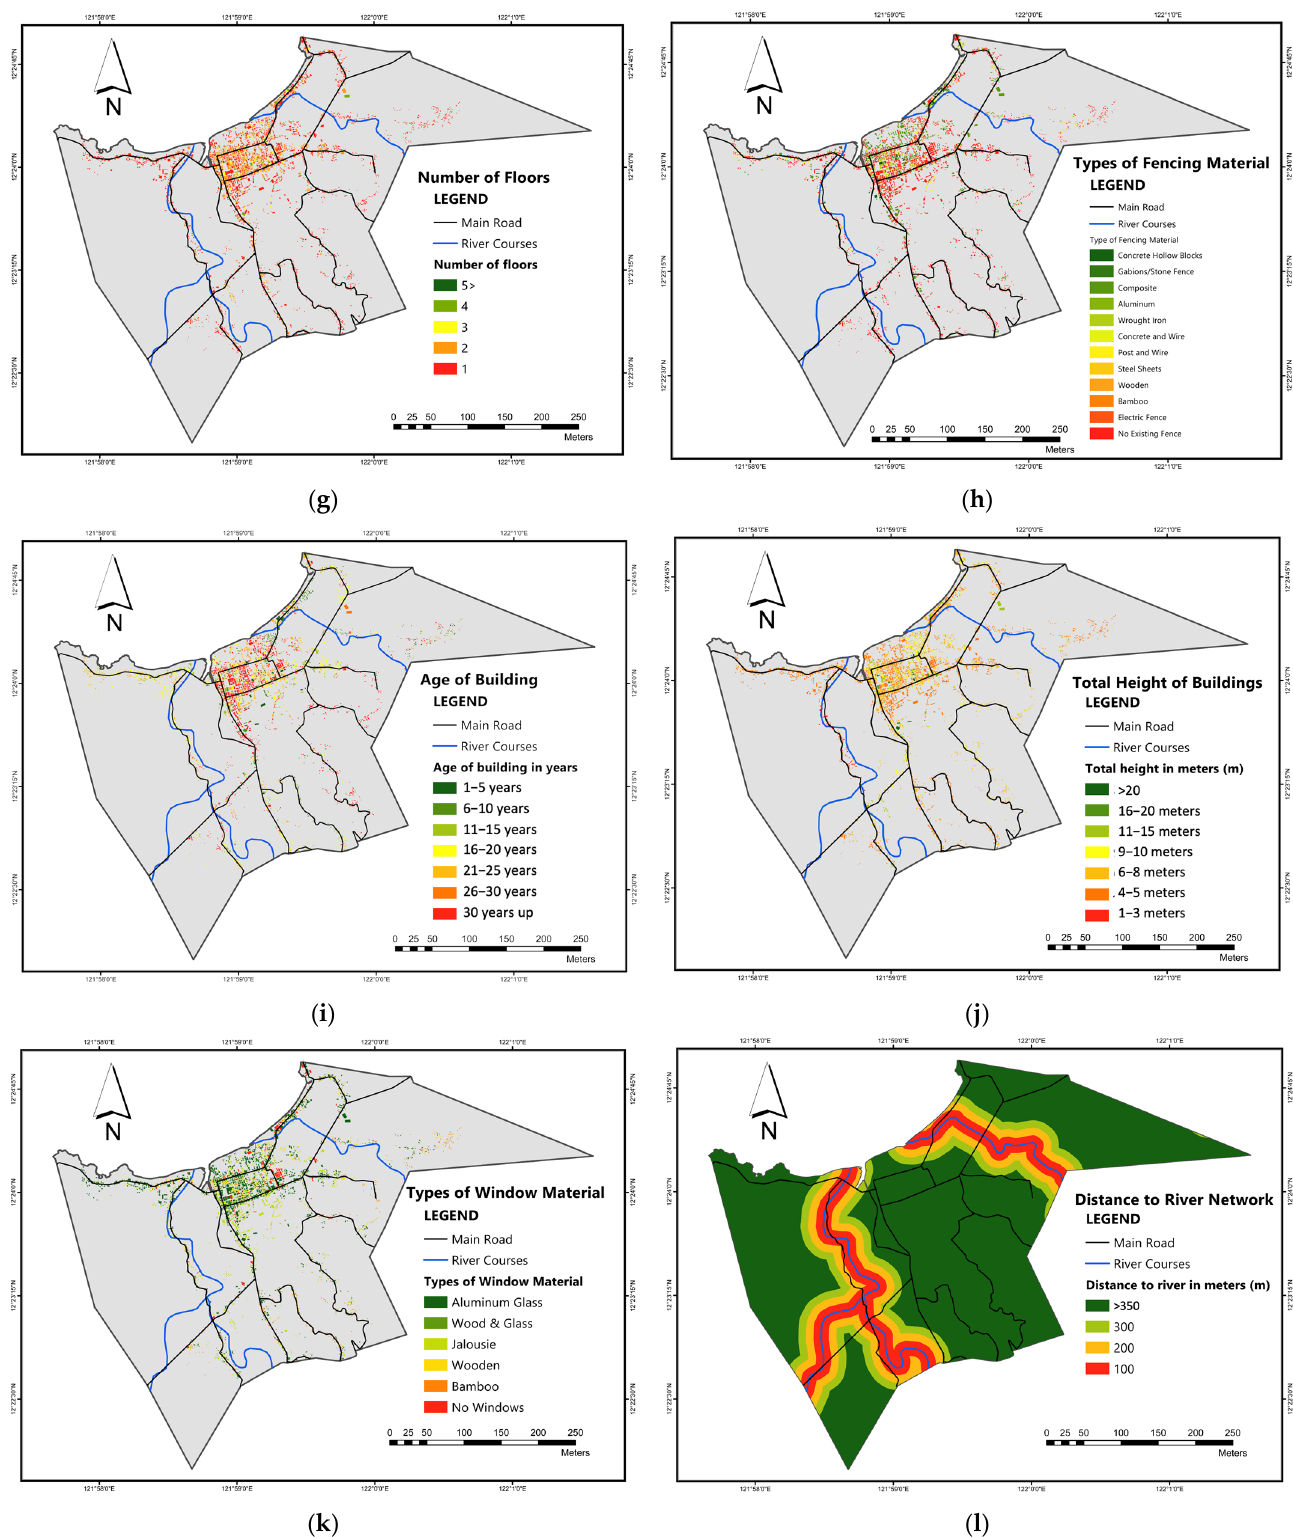
Figure 4. Building flood vulnerability parameters in the conduct of study: ( a ) annual average income, ( b ) gender ratio, ( c ) land cover, ( d ) types of roofing material, ( e ) types of flooring material, ( f ) interior/exterior walling material, ( g ) number of floors, ( h ) types of fencing material, ( i ) age of the building, ( j ) total height of the building, ( k ) types of window material, and ( l ) distance to river network.